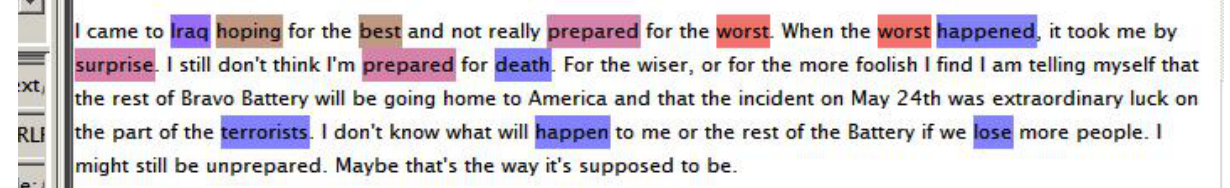
This passage follows the description of learning that some of the fellow soldiers were killed during convoy and clearly shows the deep emotional response to this